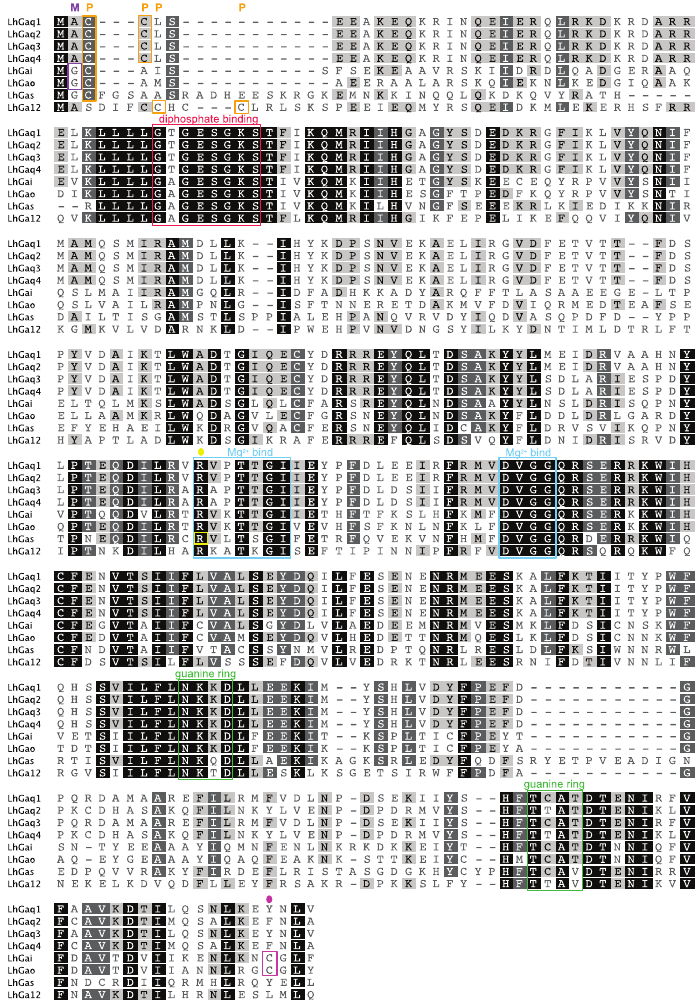
Figure 4. Multiple sequence alignment of L. hesperus G(cid:2) sequences. The respective full length L. hesperus G(cid:2) sequences were aligned in MUSCLE using default settings. Percent similarity shading is as in Figure 2. Conserved G(cid:2) subunit features/motifs are boxed: predicted myristoylation sites (purple M), predicted palmitoylation sites (orange P), diphosphate binding (red), Mg 2+ binding (blue), guanine ring binding (green), putative cholera toxin-mediated ADP-ribosylation site (Arg186) in LhG(cid:2)s (yellow circle), putative pertussis toxin-mediated ADP-ribosylation sites (Cys352/Cys351) in LhG(cid:2)i and LhG(cid:2)o (pink